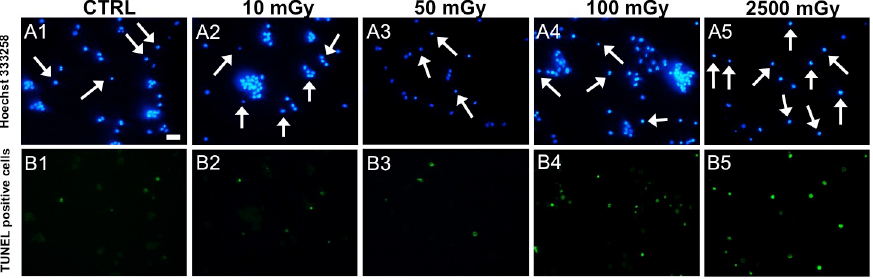
Fig 3. Effects of low-dose of X-ray radiations on cumulus cells apoptosis. Representative images of cumulus cells assessed for apoptotic index by TUNEL assay after COC exposure to X-ray radiations before IVM. Line A: nuclei stained with Hoechst 333258 (blue). Line B: TUNEL-positive nuclei stained in green. Scale bar represents 20 μ